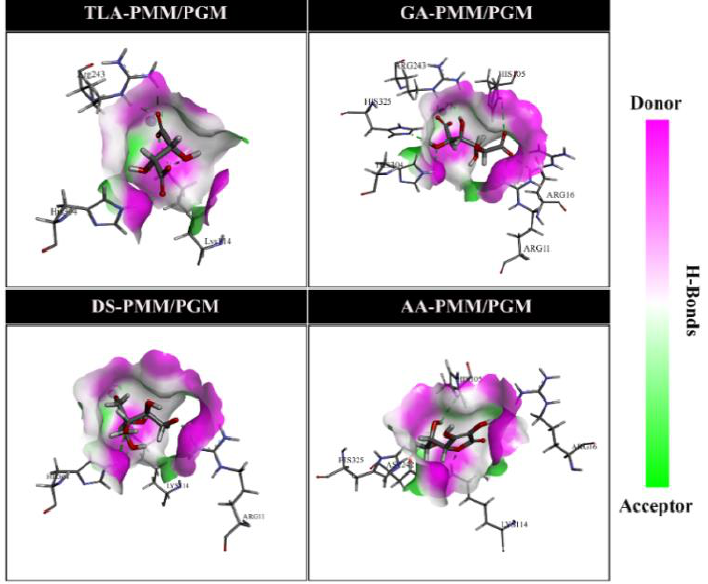
Figure 5. Hydrogen bonding pocket areas for molecular docking of phosphomannomu- tase/phosphoglucomutase by several ligands. Magenta and green indicate the hydrogen bond donor and acceptor on the pocket areas.